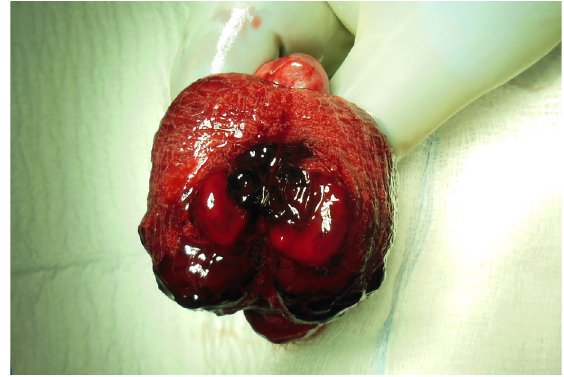
Figure 3. Gross section of the right testicle bi-valved with hematoma and surrounding intraparenchymal hemorrhage. patient was in excellent condition with complete resolution of his pain. His surgical incision was well healed and he had no evidence of intra-scrotal